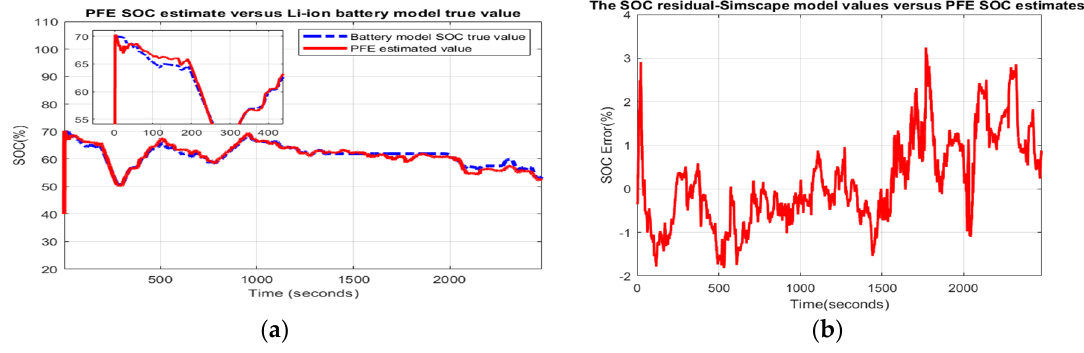
Figure A28. Robustness to changes in SOC initial value—SOCini = 0.4. ( a ) PFE SOC estimate versus battery SOC true value; ( b ) SOC residual.